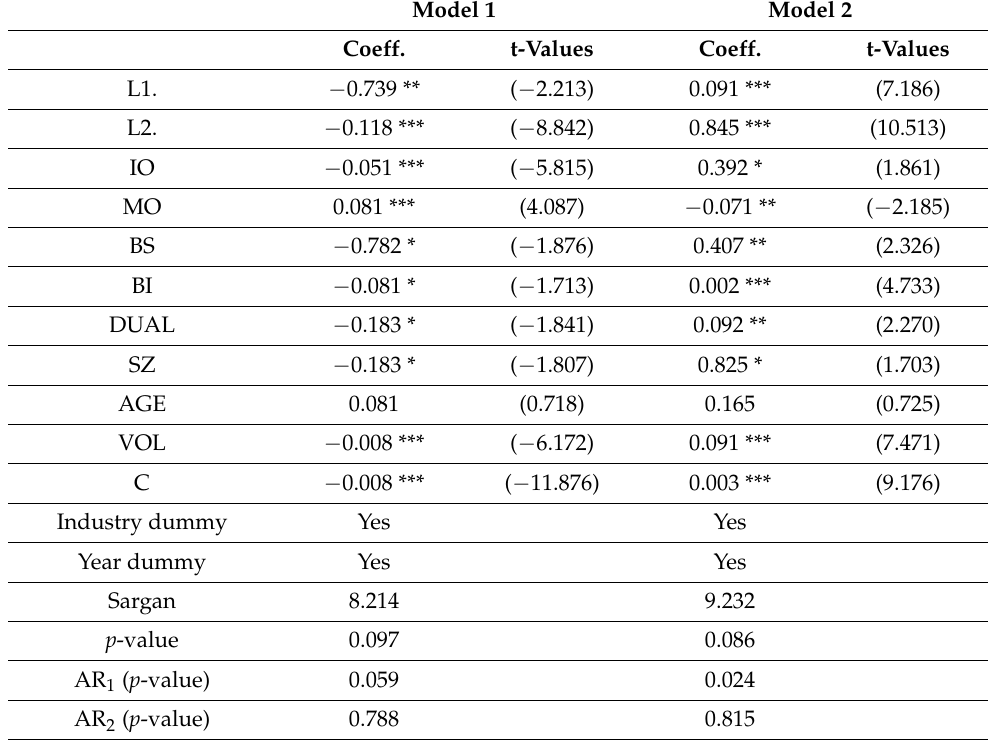
Table 6. Dynamic panel